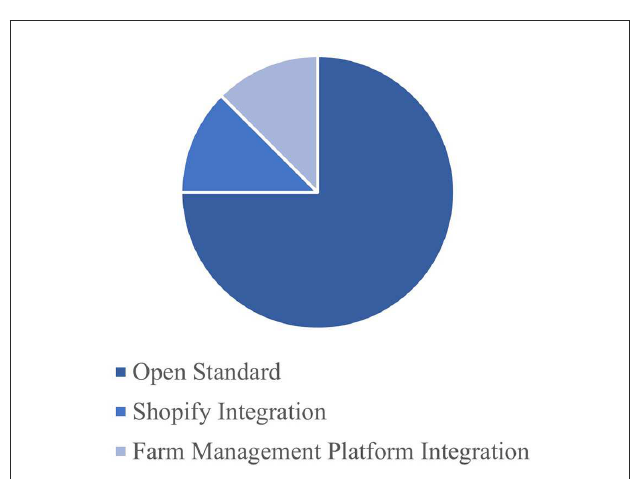
FIGURE5 Preference for specific interoperability